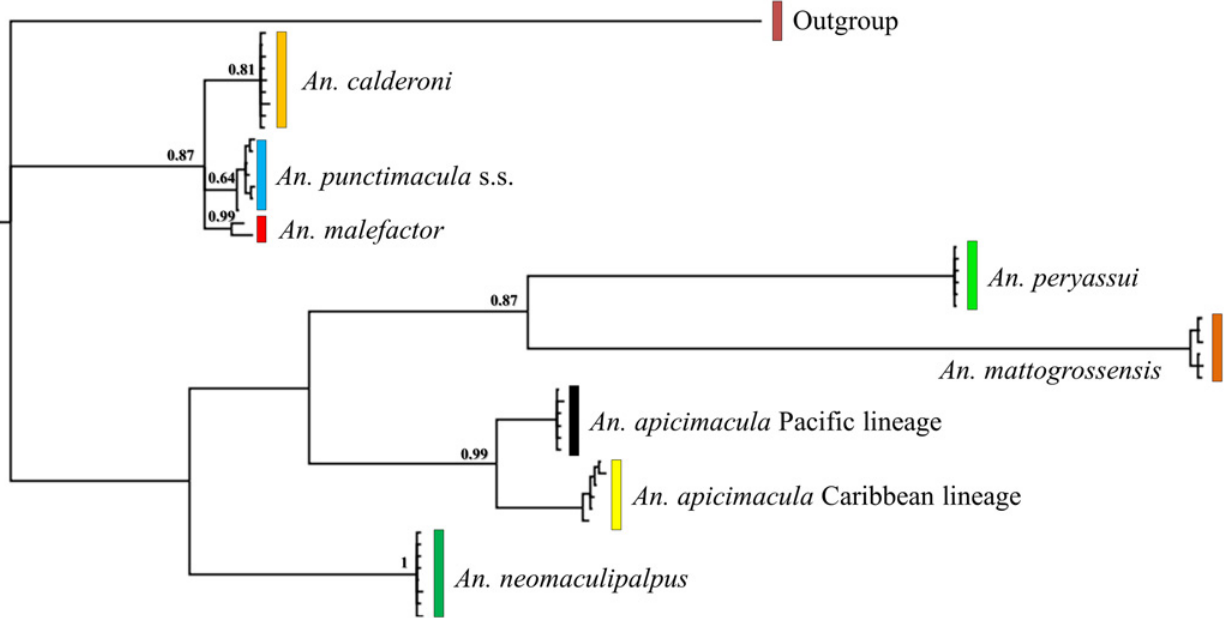
Fig 3. Bayesian topology of ITS2 sequences for species of the Arribalzagia Series. Numbers on each branch represent posterior probabilities. Anopheles pseudopunctipennis was the